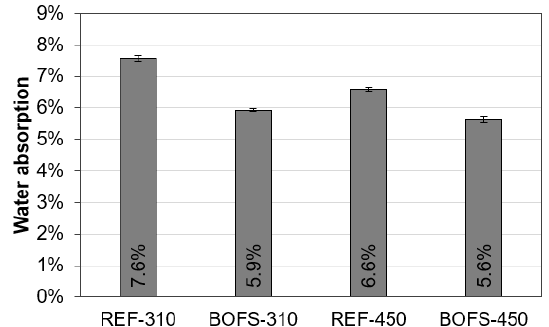
Figure 4. Water absorption of the concretes produced in the hardened